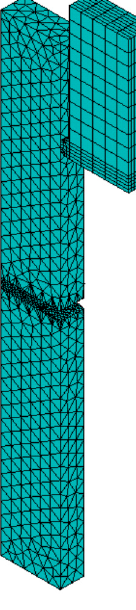
Figure 7. Finite element models of the specimen and pendulum hammer.